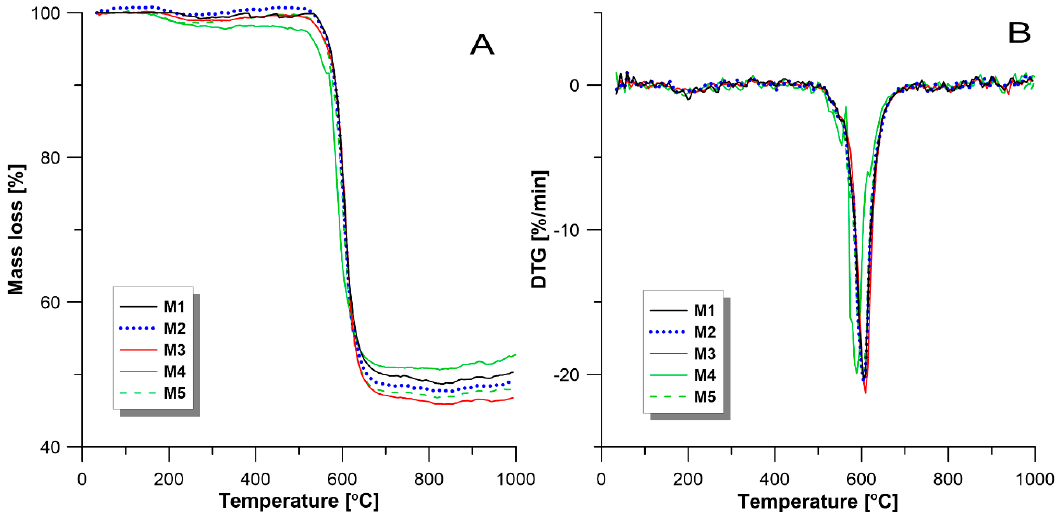
Figure 9. ( A ) represents the TGA curves of PPSU membranes and ( B ) represents the DTG curves of PPSU membranes. Table 3. Thermal properties of PPSU based membranes.